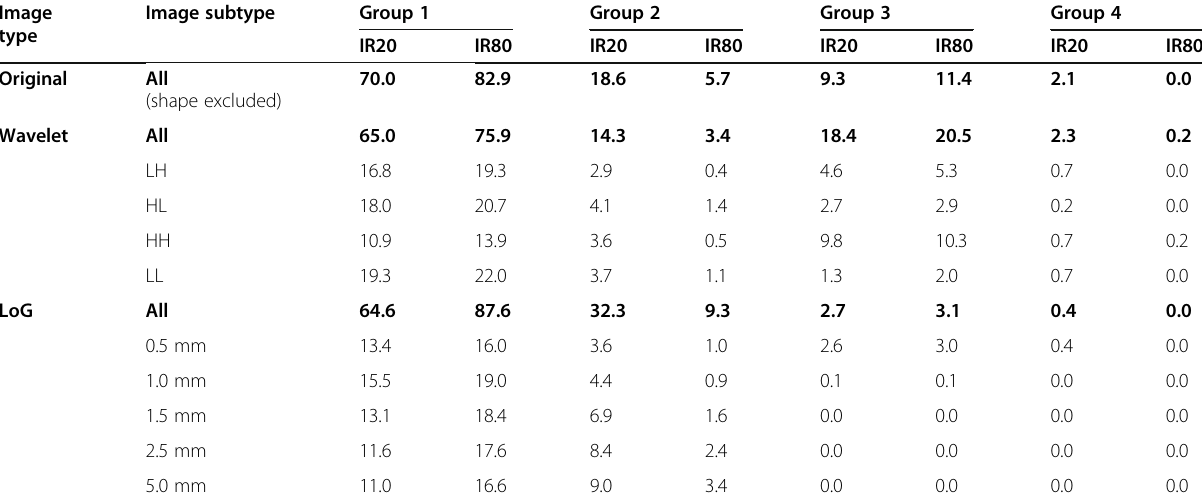
Table 4 Percentage of features falling in each of the four groups Image